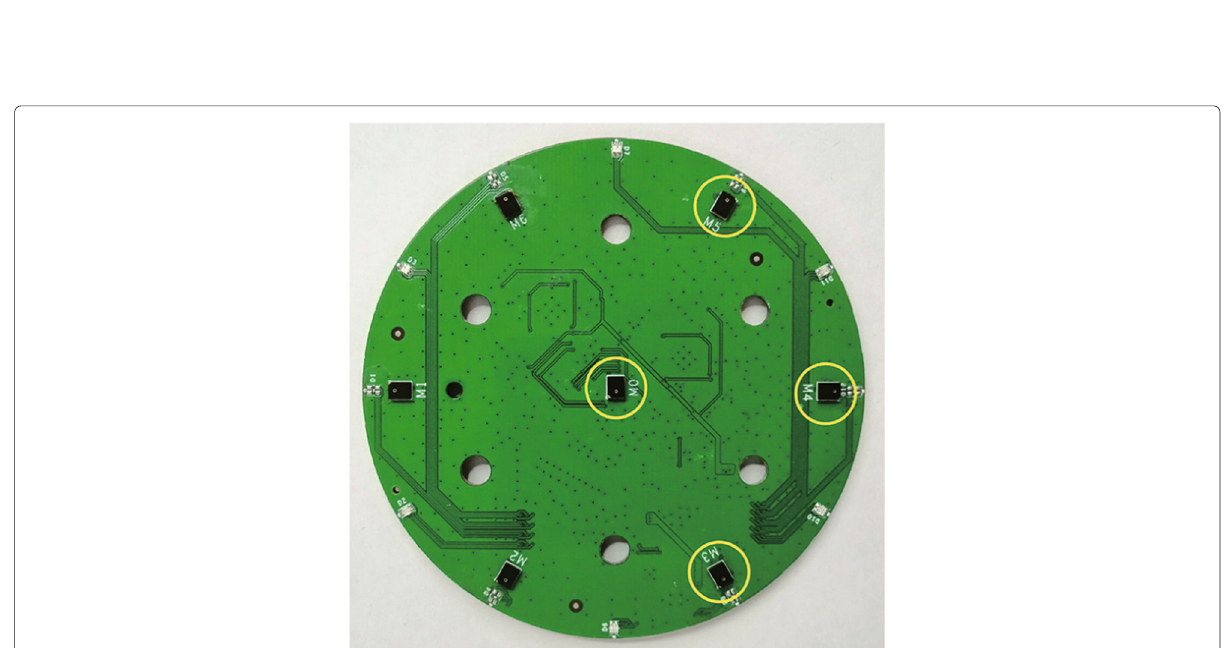
Fig. 11 A photo of the designed microphone arrays and the used irregularity microphone array with 4 microphones (marked with a